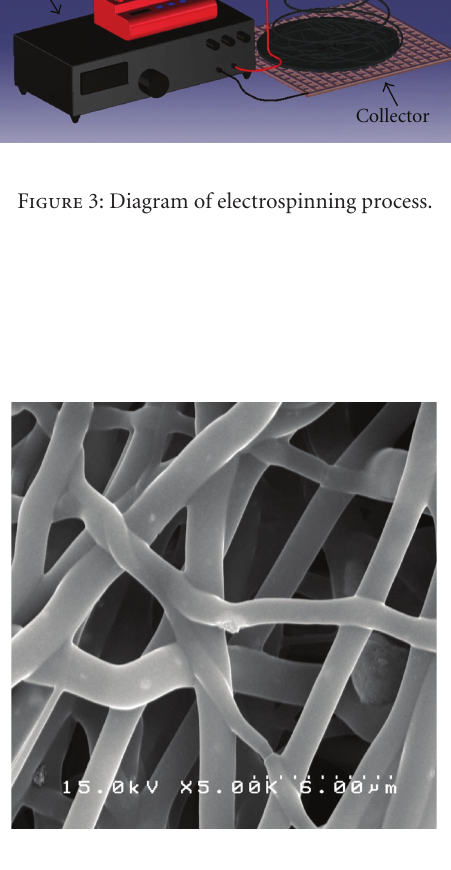
Figure 4: Electrospun fibers of PVP containing magnetic nanopar- ticles.